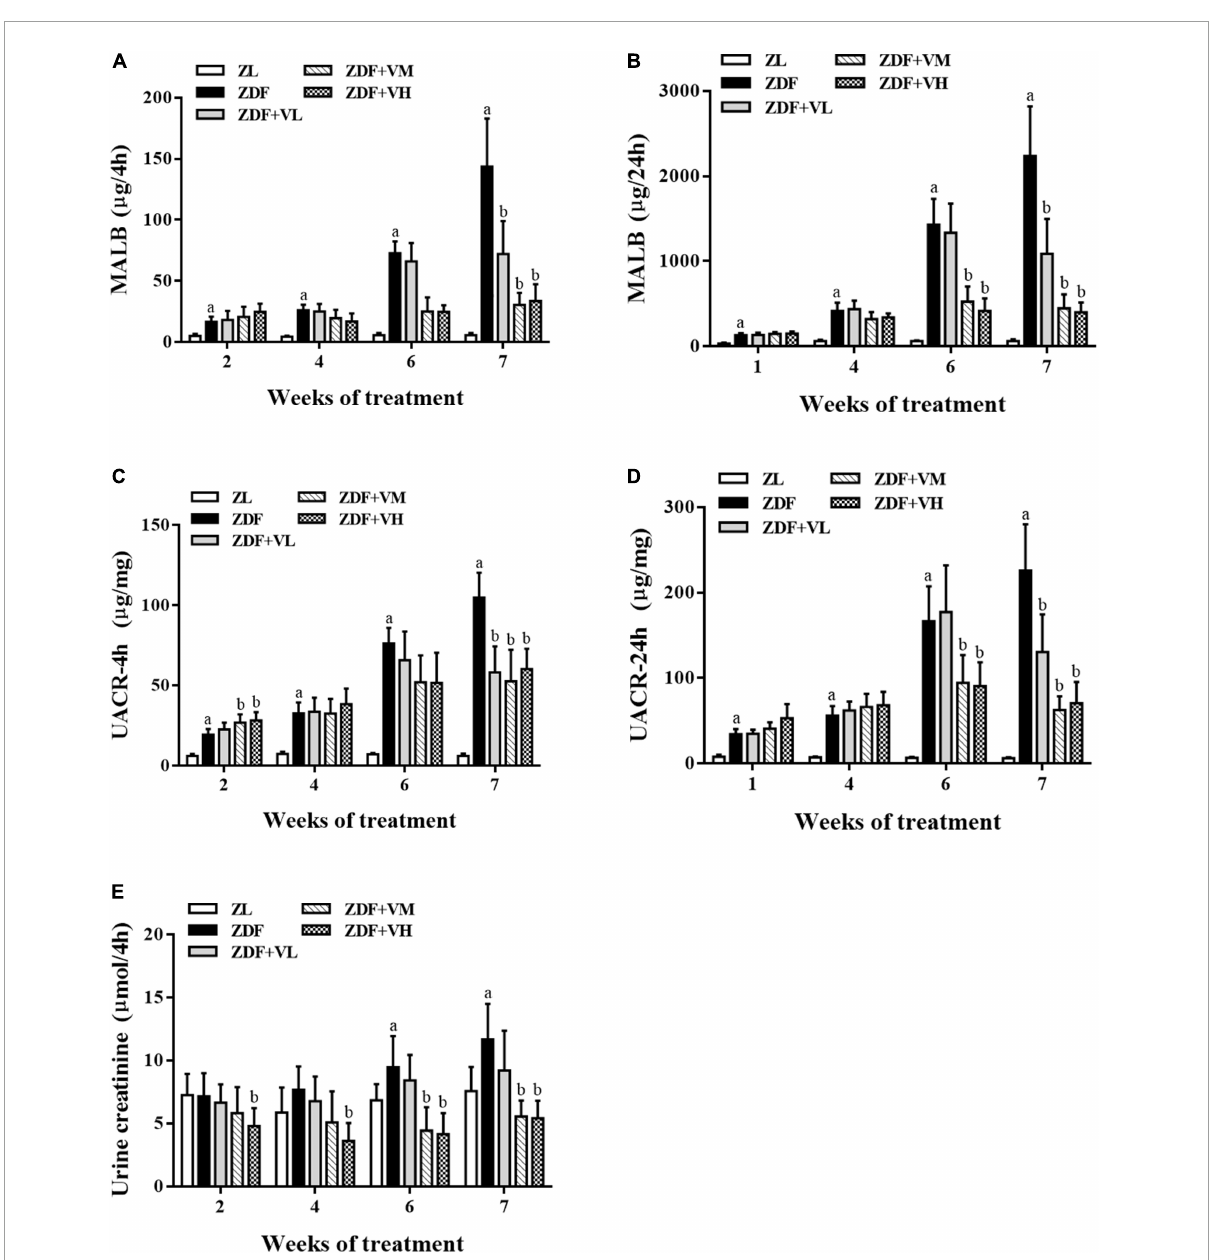
FIGURE2 Variation trend of renal function indicators as weeks of 1,25(OH) 2 D 3 treatment. (A,B) Four hour-MALB and 24 h-MALB contents. (C,D) Four hour-UACR and 24 h-UACR contents. (E) Four hour-Urine creatinine content. ZL, Zucker lean group; ZDF, Zucker diabetic fatty group; ZDF + VL, ZDF + low-dose 1,25(OH) 2 D 3 group (2 µ g/kg · bw); ZDF + VM, ZDF + middle-dose 1,25(OH) 2 D 3 group (8 µ g/kg · bw); ZDF + VH, ZDF + high-dose 1,25(OH) 2 D 3 group (16 µ g/kg · bw). Data are presented as mean ± SD (n ≥ 4). a P < 0.05 vs. the ZL group, b P < 0.05 vs. the ZDF group.